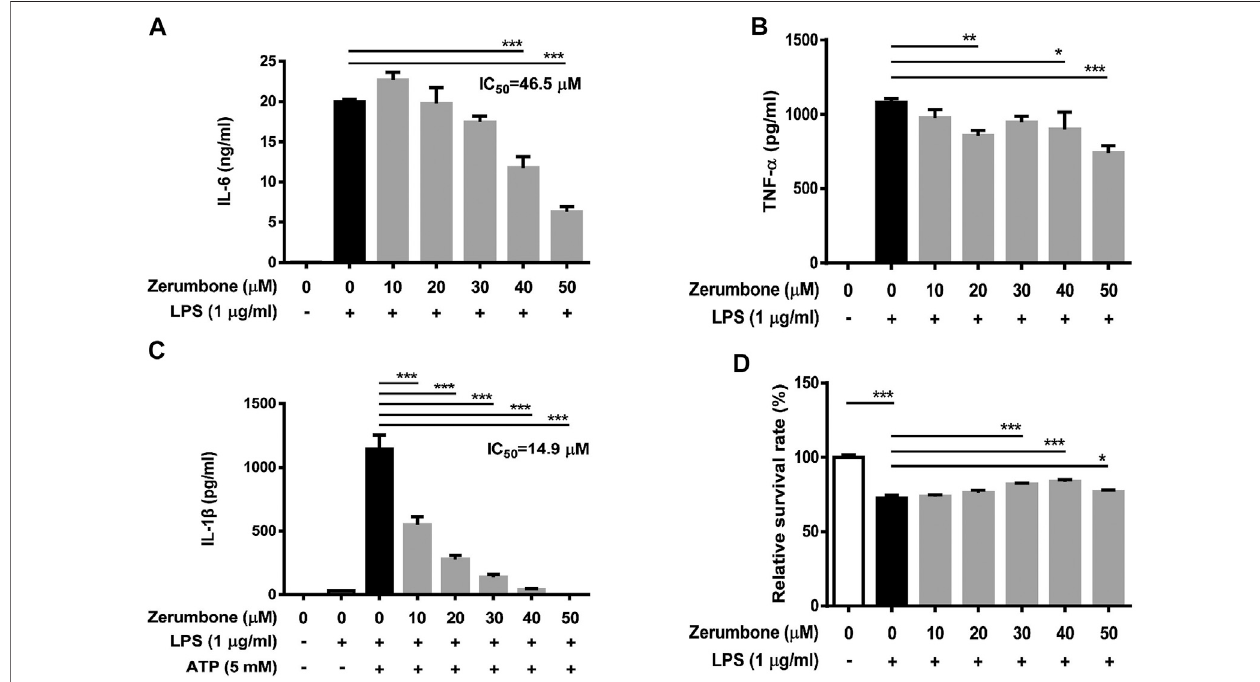
FIGURE 7 | The effects of zerumbone on the cell viability and IL-6, TNF- α , and IL-1 β productions in LPS- or LPS/ATP-activated murine bone marrow-derived macrophages. Cells were pre-treated with various doses of zerumbone for 1 h following treatment of LPS (1 μ g/ml) for 24 h. The expression levels of (A) IL-6 and (B) TNF- α were measured using ELISA. Statistical signi fi cance between the zerumbone-treated groups vs. the LPS-only group is represented as follows: * p < 0.05, ** p < 0.01 and *** p < 0.001. (C) For the IL-1 β secretion, cells were pre-treated with various doses of zerumbone for 1 h and then treated with LPS (1 μ g/ml) for 5 h following treatment of ATP (5 mM) for 30 min. Cell culture supernatants were collected and the levels of IL-1 β were determined by ELISA. Data were represented as means ± SD. Statistical signi fi cance between the zerumbone-treated groups vs. the LPS-only group is represented as follows: *** p < 0.001. (D) Cell viability was analyzed by MTT assay. Statistical signi fi cance between the zerumbone-treated groups vs. the LPS-only group is represented as follows: * p < 0.05 and *** p < 0.001.